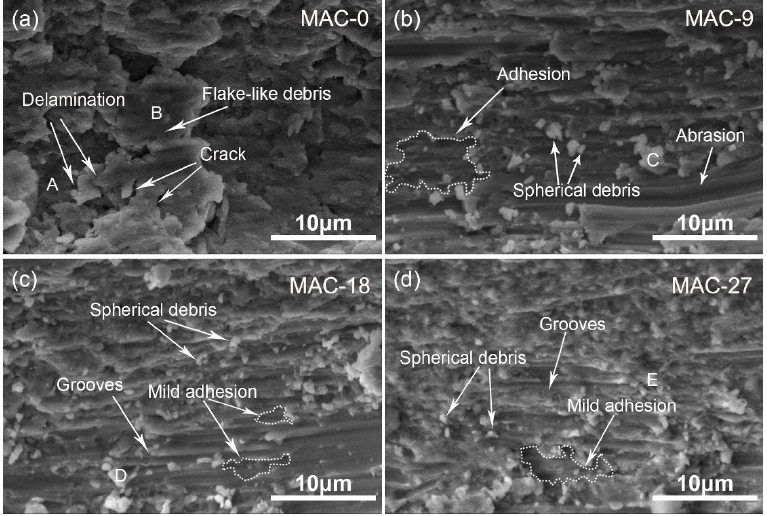
Figure 8. SEM images of the wear scars after the fretting test: ( a ) MAC-0, ( b ) MAC-9, ( c ) MAC-18, and ( d ) MAC-27.